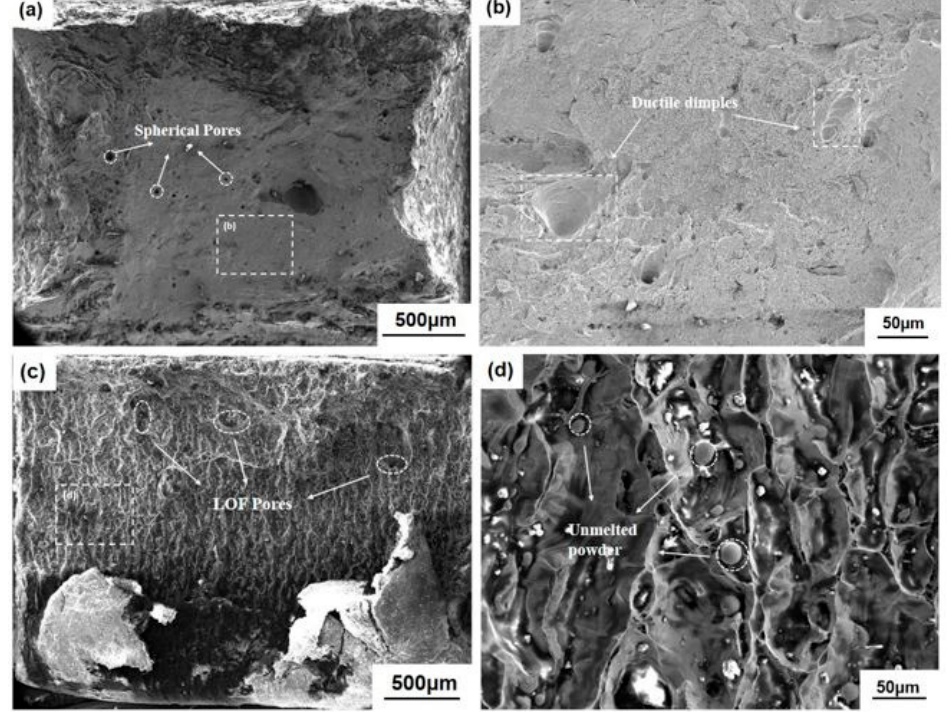
Figure 11. Fracture morphology of ( a , b ) Specimen 400 and ( c , d ) Specimen 1000 obtained by SEM.